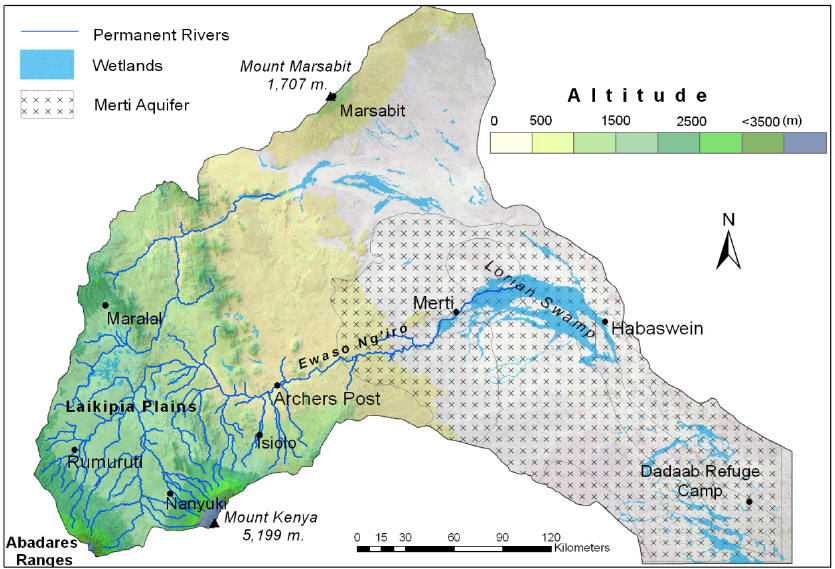
Figure 1. Map of the Ewaso Ng’iro River Basin, the Lorian Swamp and the Merti Aquifer. The wetlands in the lower parts of the catchment are